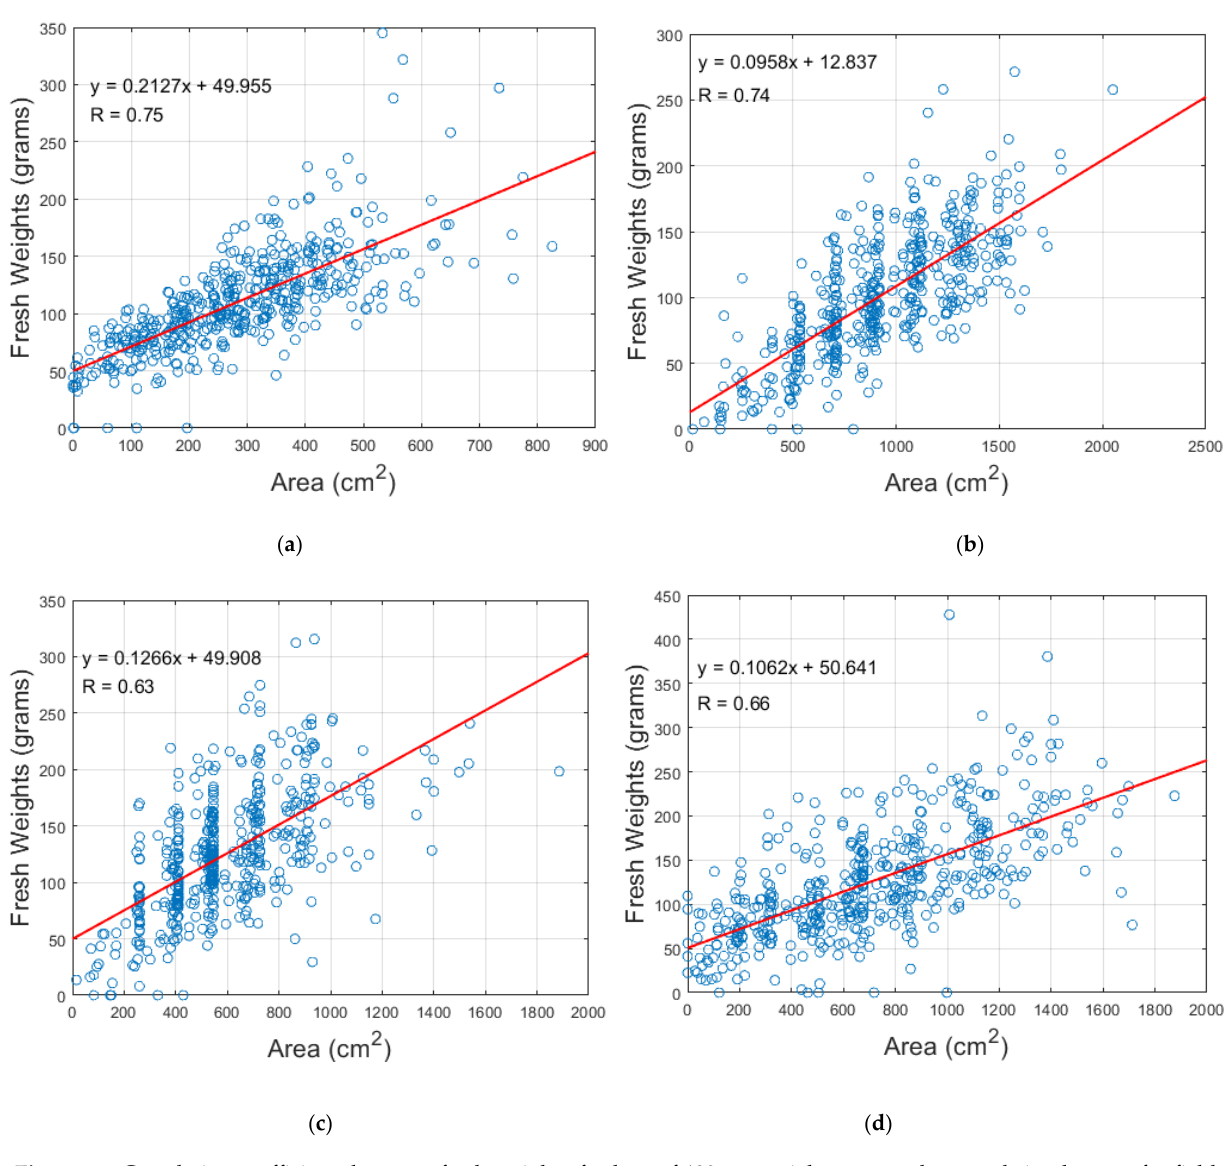
Figure 12. Correlation coefficients between fresh weight of subset of 480 perennial ryegrass plants and circular area for field trial images taken on ( a ) 9 May 2017, ( b ) 5 July 2017, ( c ) 11 September 2017 and ( d ) 20 November 2017.